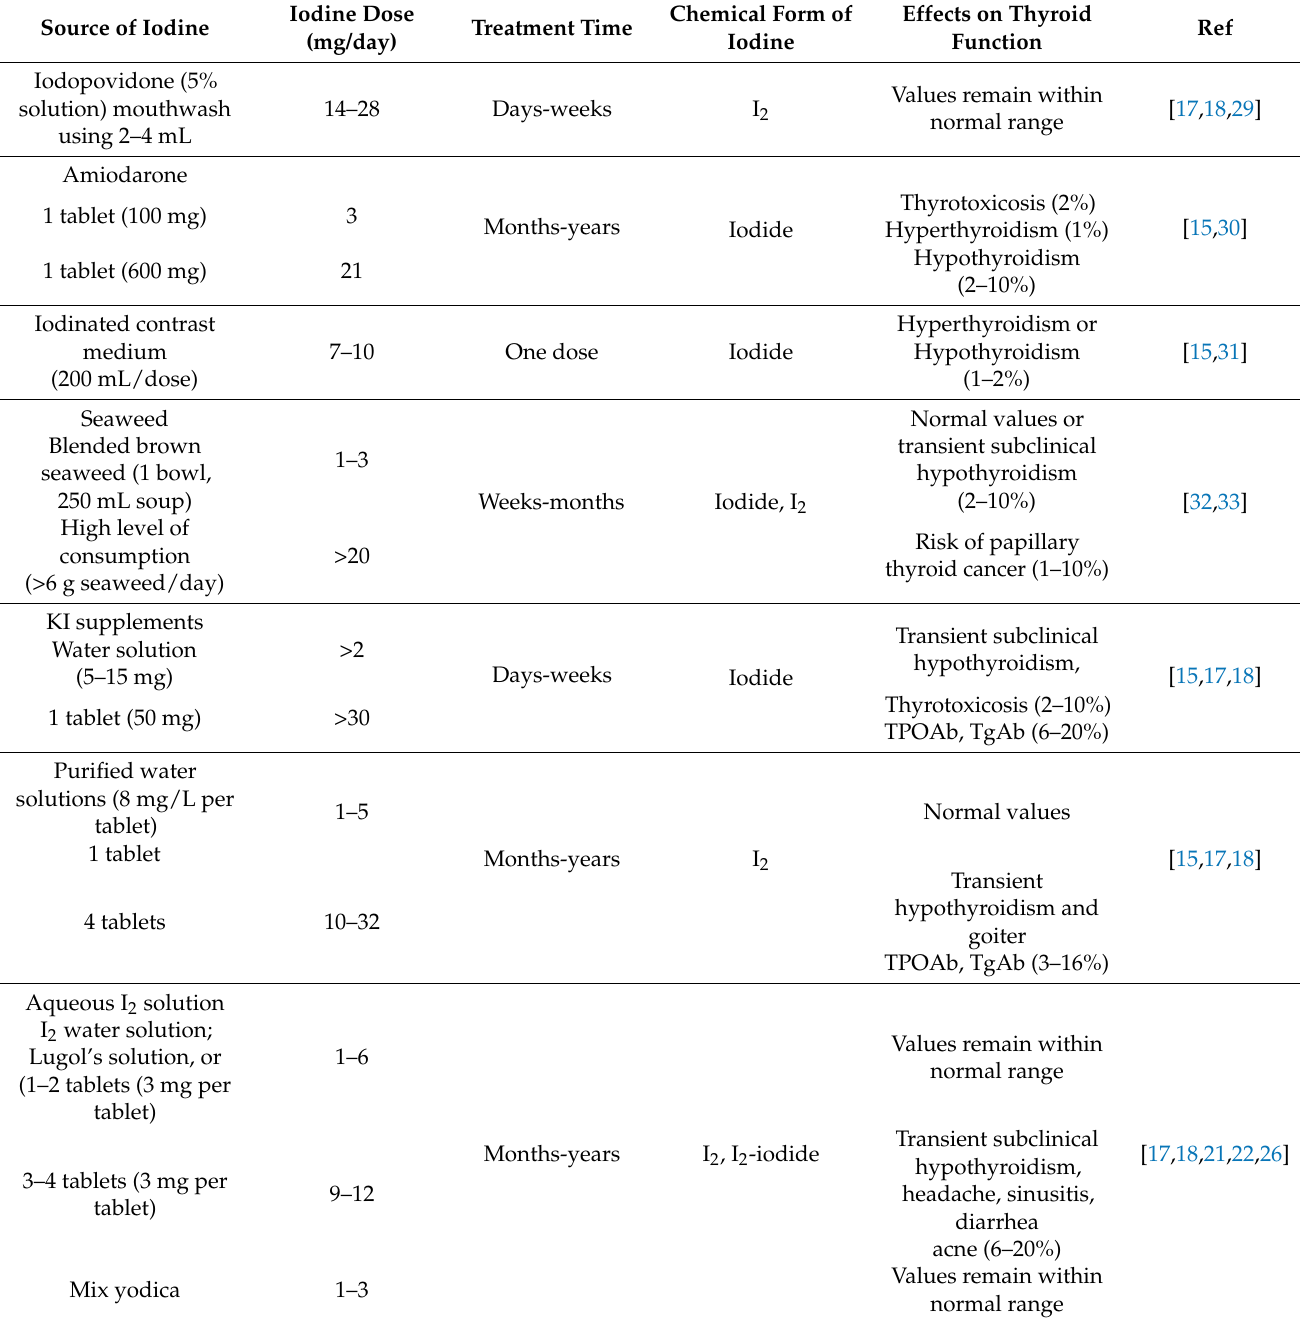
Table 2. Sources and Effects of Excess